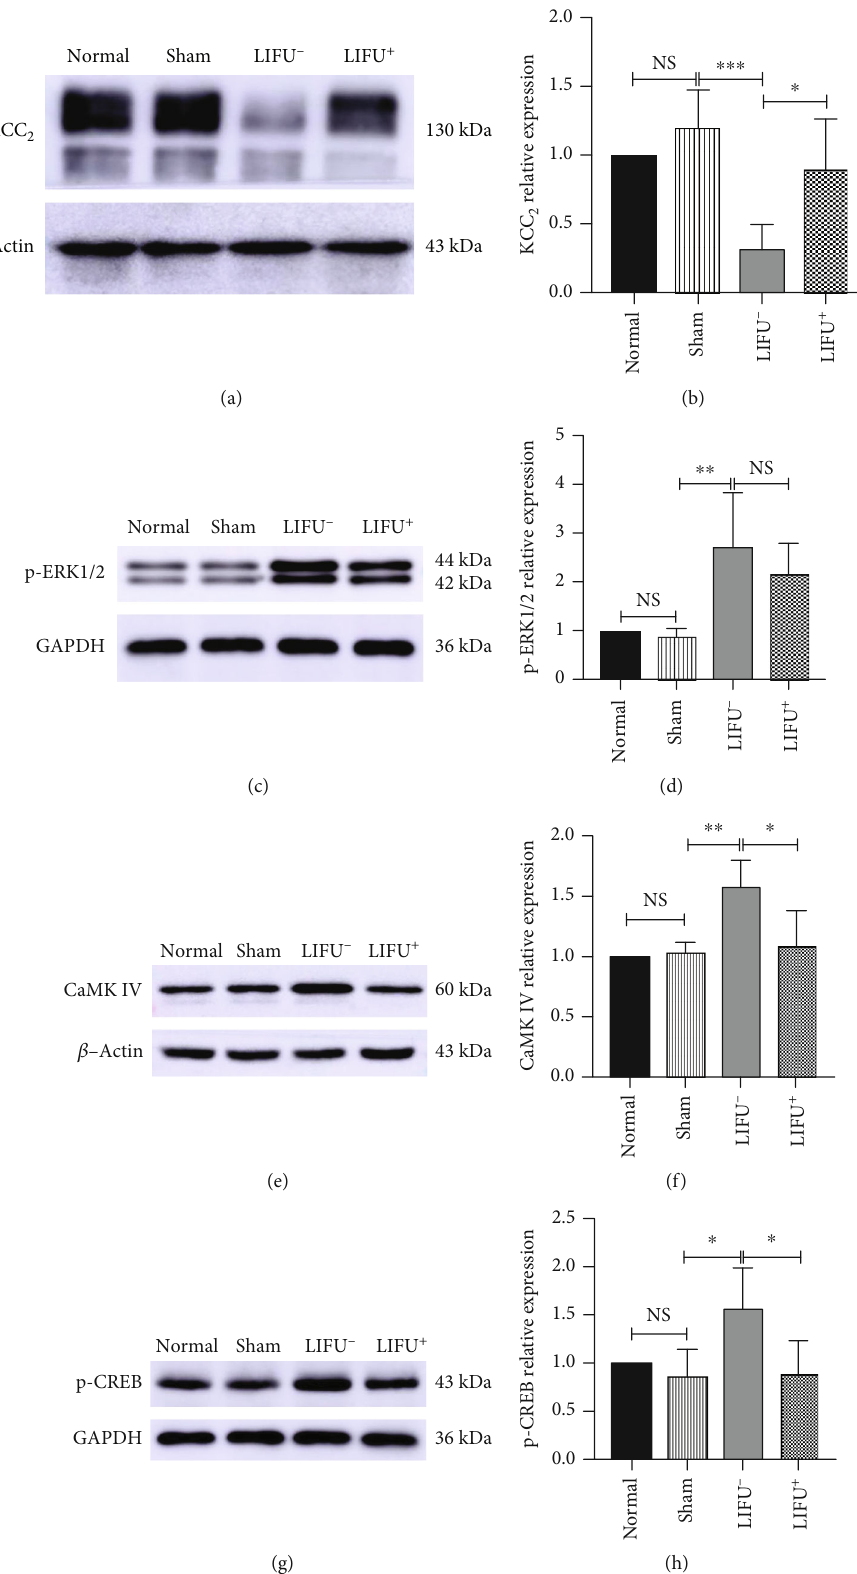
Figure 4: WB analysis of KCC (a, b), p-ERK1/2 (c, d), CaMKIV (e, f), and p-CREB (g, h) expression in the L4 – L5 section of the spinal cord in 2 di ff erent groups at 4 weeks post-LIFU treatment. Values, normalized to β -actin, or GAPDH. Each symbol represents the mean ± SEM ; ∗ P < 0 : 05 , ∗∗ P < 0 : 01 , ∗∗∗ P < 0 : 001 . One-way ANOVA; n = 5 rats per